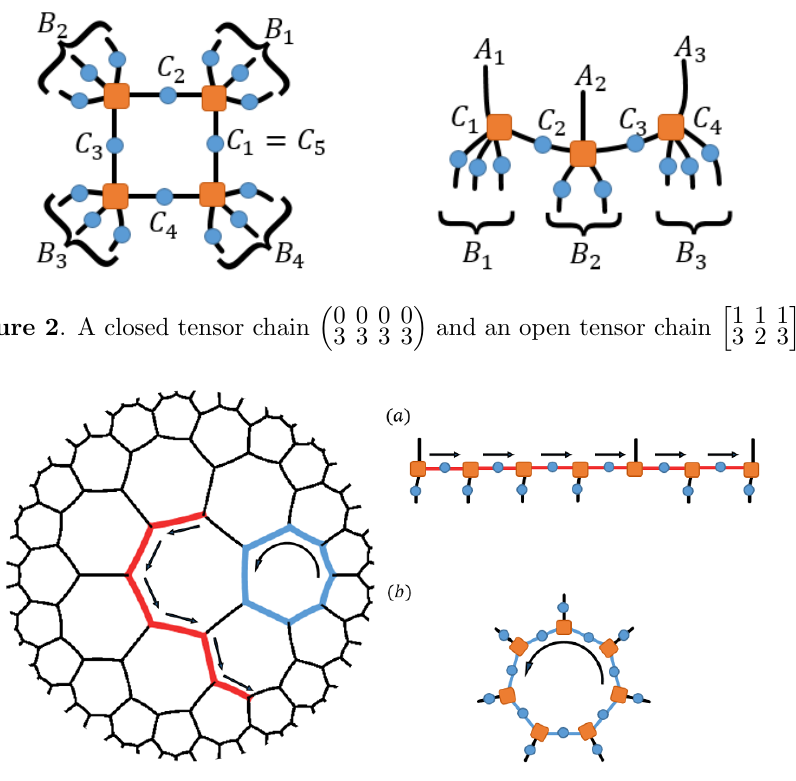
Figure 3 . Two polylines and their tensor chains in a tensor network with f 7 ; 3 g tiling. The tensor chain of red polyline is shown in (a) and the tensor chain of blue polyline is shown in